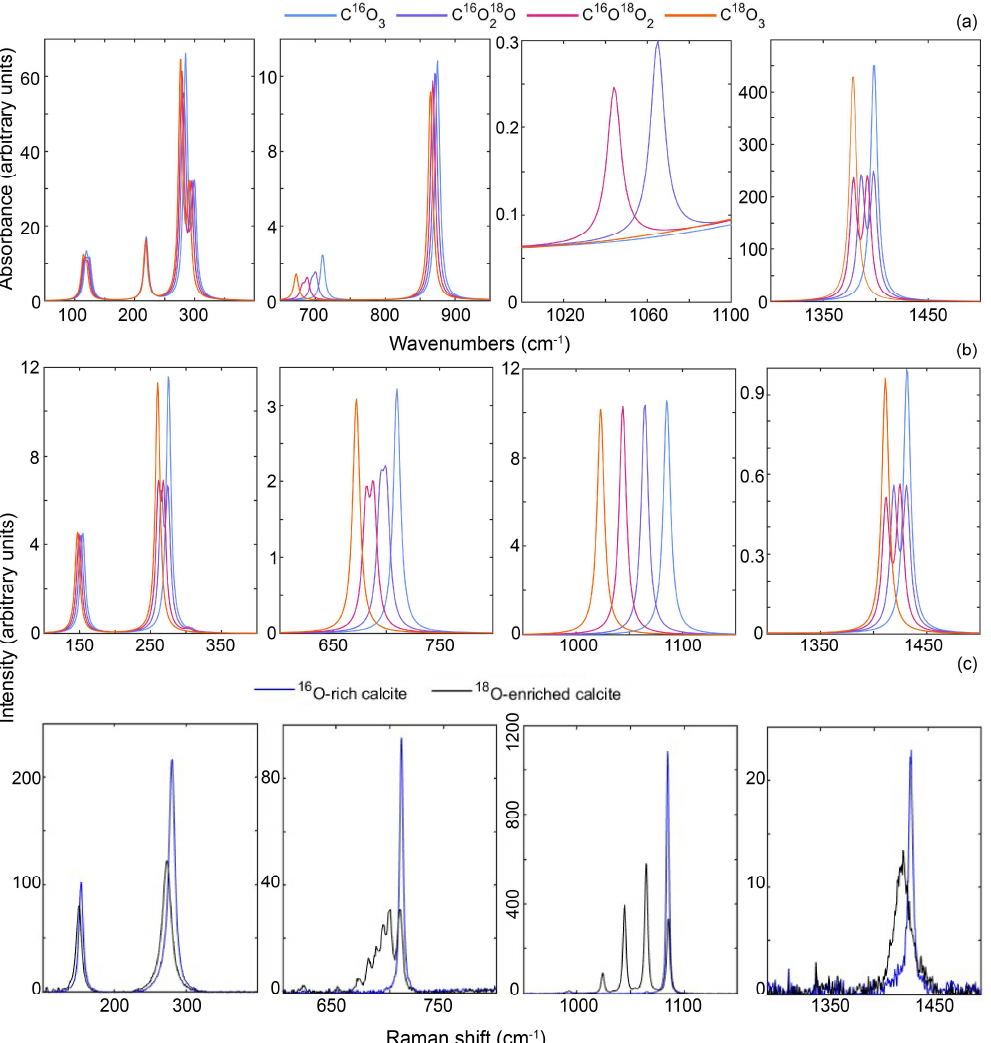
Figure 1. Calculated vibrational spectrum of calcite with each of the four carbonate O − isotopologues: ( a ) infrared spectrum, ( b ) Raman spectrum, where ( c ) shows the experimentally determined Raman spectrum from a single calcite crystal. The regions outside of the plotted areas have no vibrational bands visible. Note that the individual regions of interest are plotted with different y axes to facilitate